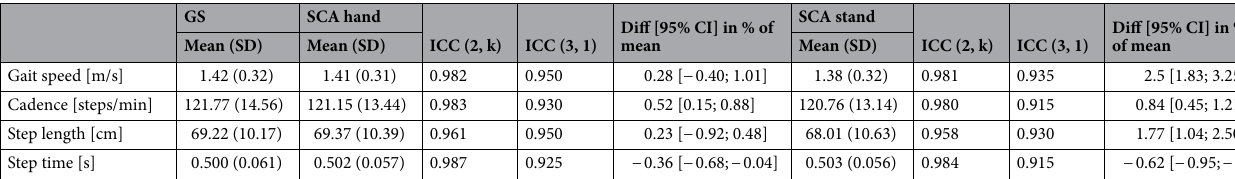
Table 1. Statistical comparisons between GS and SCA (Hand and Stand) averaged over preferred and fast gait speed trials. Means and standard deviations (SD) are reported together with inter-class-correlation coefficients, ICC (2, k), for multiple gait parameters, inter-trial repeatability as measured by ICC (3, 1), and measurement differences between the two systems (GS and SCA) in terms of mean values with lower and upper bounds of confidence intervals (Diff [95% CI]) transformed to percentage of